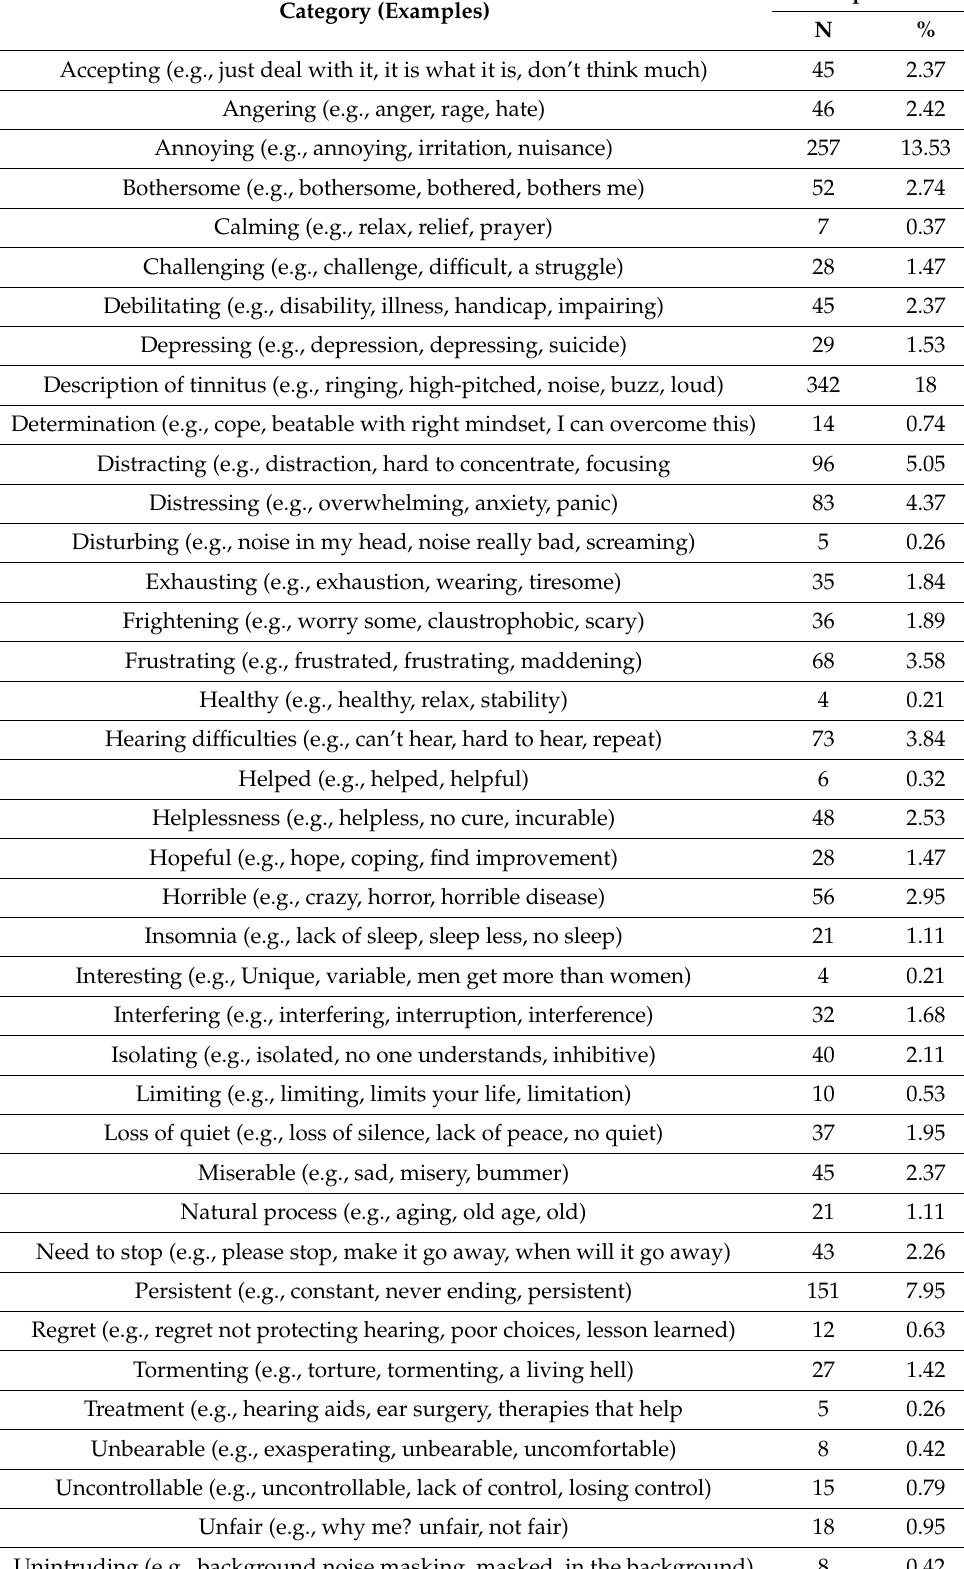
Table 2. Percentage of categories for